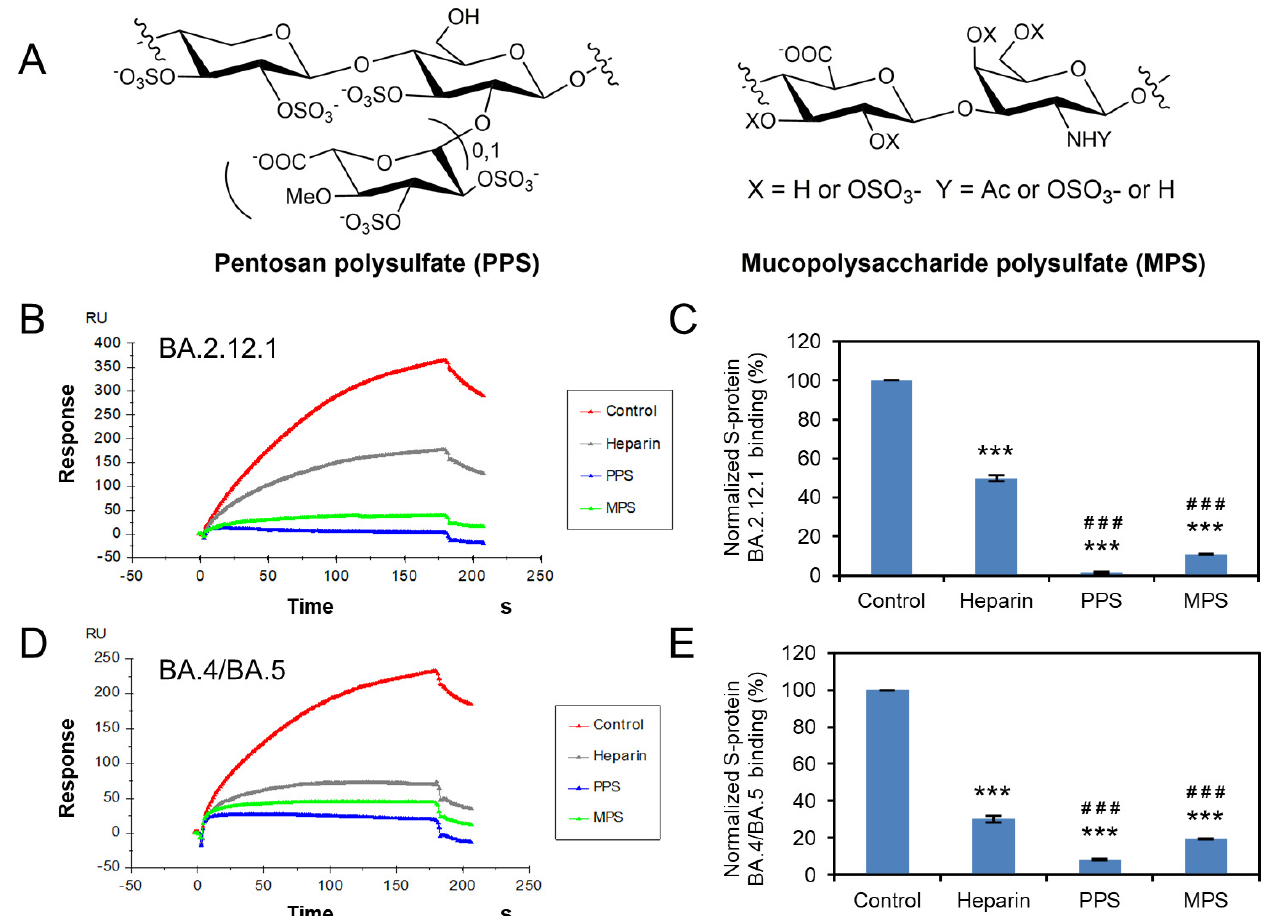
Figure 6. Solution competition between heparin and PPS or MPS. ( A ) Structure of PPS and MPS. ( B ) SPR sensorgrams of S protein RBD (BA.2.12.1)–heparin interaction competing with PPS or MPS. Concentration of S-protein RBD (BA.2.12.1) is 250 nM mixed with 1 µ M of PPS or MPS. ( C ) Bar graphs (based on triplicate experiments with standard deviation) of normalized S-protein RBD (BA.2.12.1) binding preference to surface heparin by competing with PPS or MPS. ( D ) SPR sensorgrams of S protein RBD (BA.4/BA.5)–heparin interaction competing with PPS or MPS. Concentration of S-protein RBD (BA.4/BA.5) is 250 nM mixed with 1 µ M of PPS or MPS. ( E ) Bar graphs (based on triplicate experiments with standard deviation) of normalized S-protein RBD (BA.4/BA.5) binding preference to surface heparin by competing with PPS or MPS. Statistical analysis was performed using unpaired two-tailed t -test (***: p ≤ 0.001 compared to the control, ###: p < 0.001 compared to the